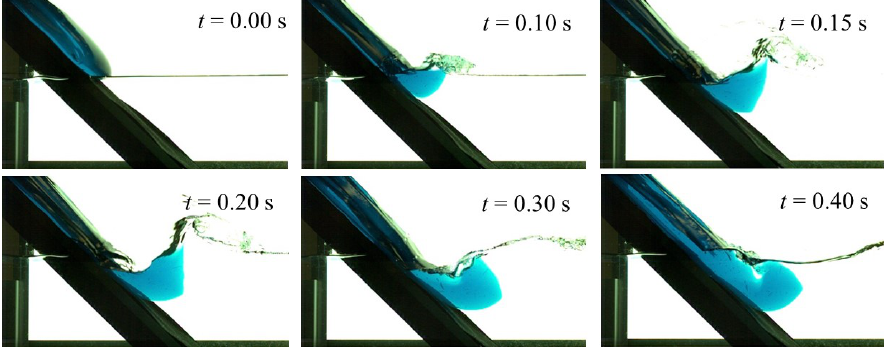
Figure 4. Raw images of the selected experiment, recorded by the high-speed